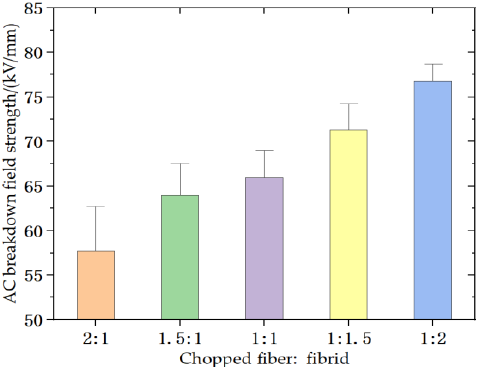
Figure 9. AC breakdown strength of oil-impregnated paper with different fiber ratios.